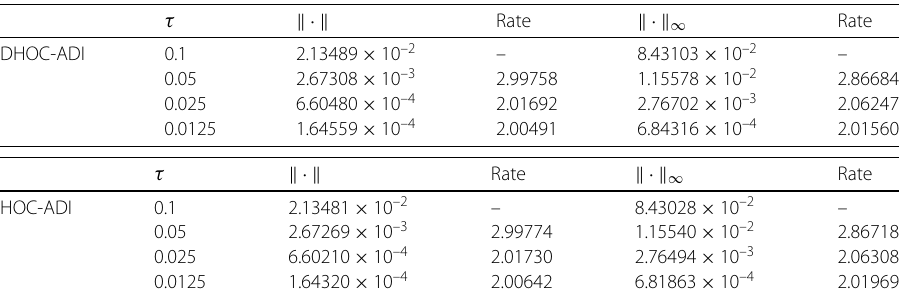
Table 5 The error norms of numerical solutions and the rate of convergence in time where h x = h y =